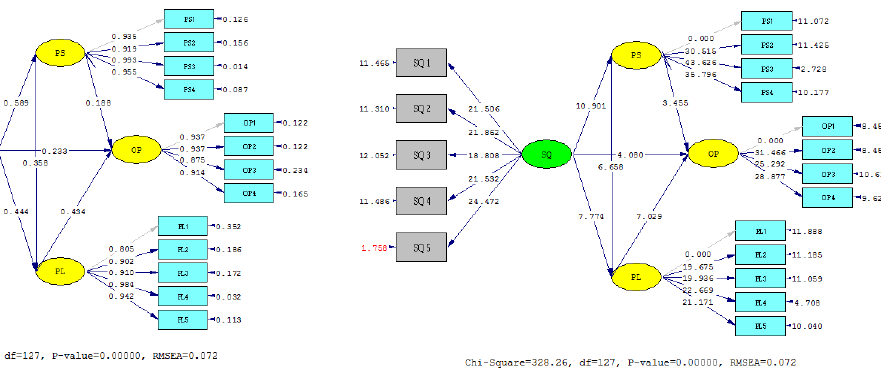
Fig. 2. Result of full Structural model testing (Standardized) Fig. 3. Result of full Structural model (T